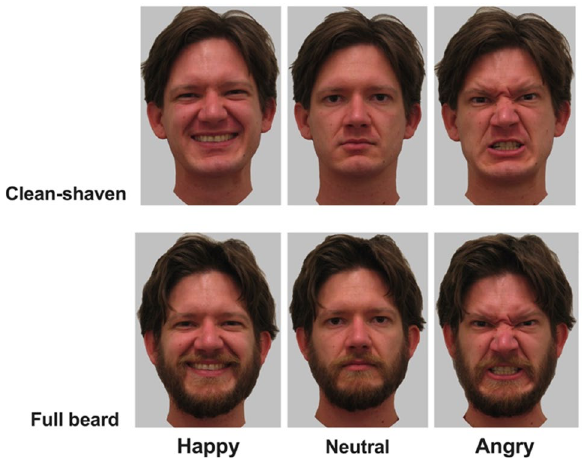
Figure 1. Examples of the stimuli used in Studies 1–3. Clean-shaven faces are shown in the top row and bearded faces on the bottom row. Faces from left to right show happy, neutral, and angry expressions.